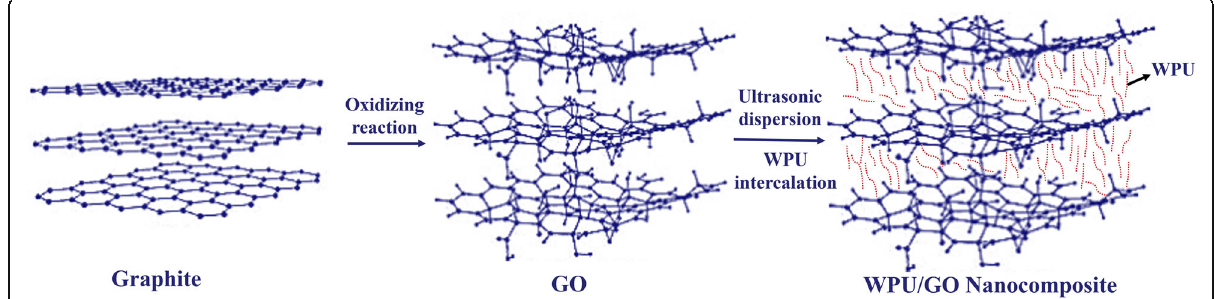
Fig. 2 Preparation of GO ( a , graphite; b , GO) and WPU/GO composite ( c ) [39]. Copyright 2010, American Chemical